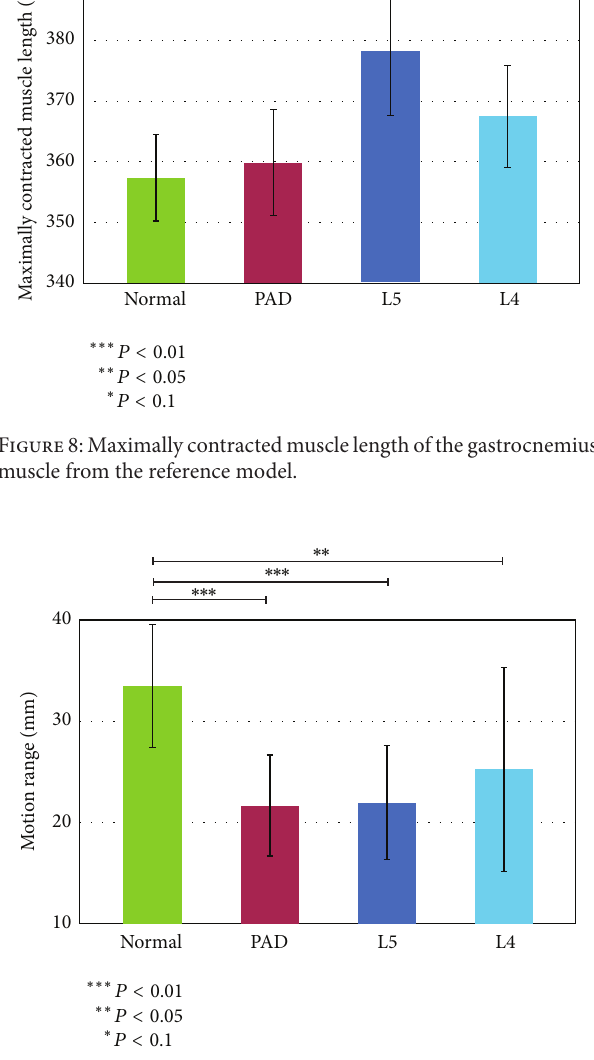
Figure 9: Range of motion of the gastrocnemius muscle from the reference